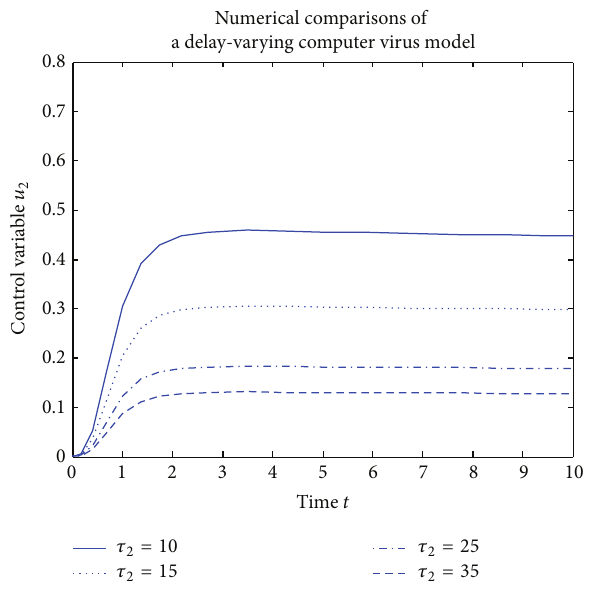
Figure7:Thecontrolvariable 𝑢 2 (𝑡) versustime 𝑡 fordifferentweight